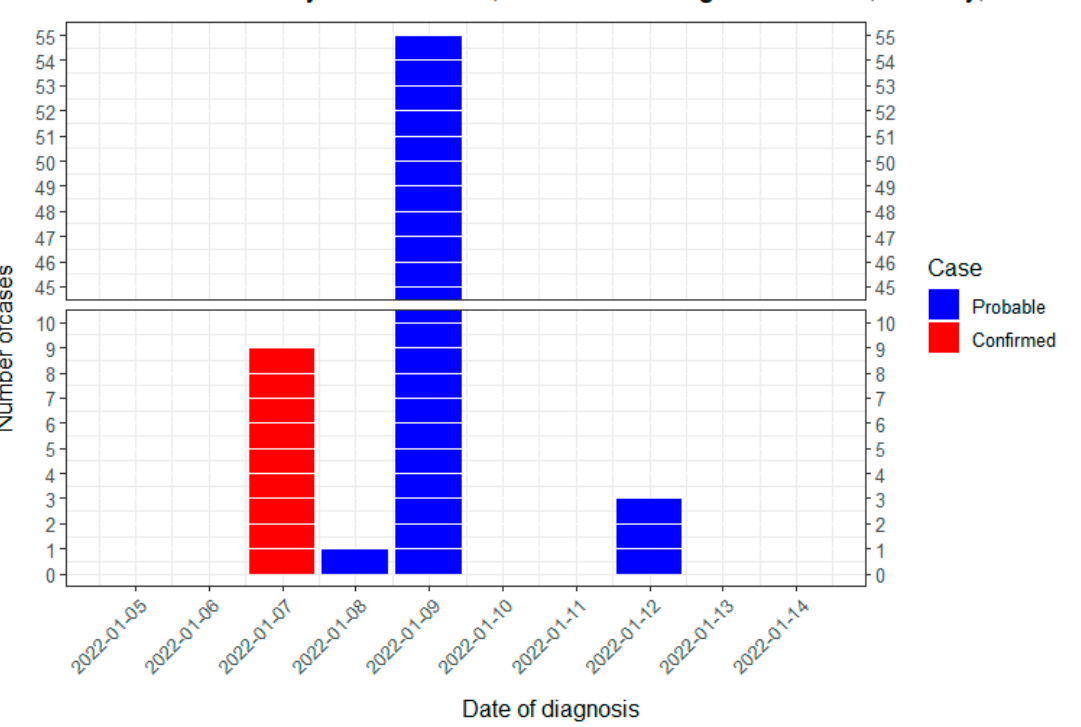
Figure 1. Epidemic curve of confirmed and probable cases. Nine cases were initially identified by PCR on 7 January 2022; then a further 56 showed positive RAT tests on 8 and 9 January, and the last 3 were identified on 12 January 2022.